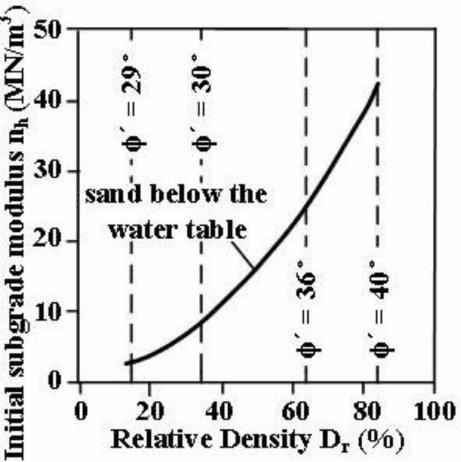
Figure 9. Relationship of the initial modulus of subgrade reaction, the effective friction angle, and relative